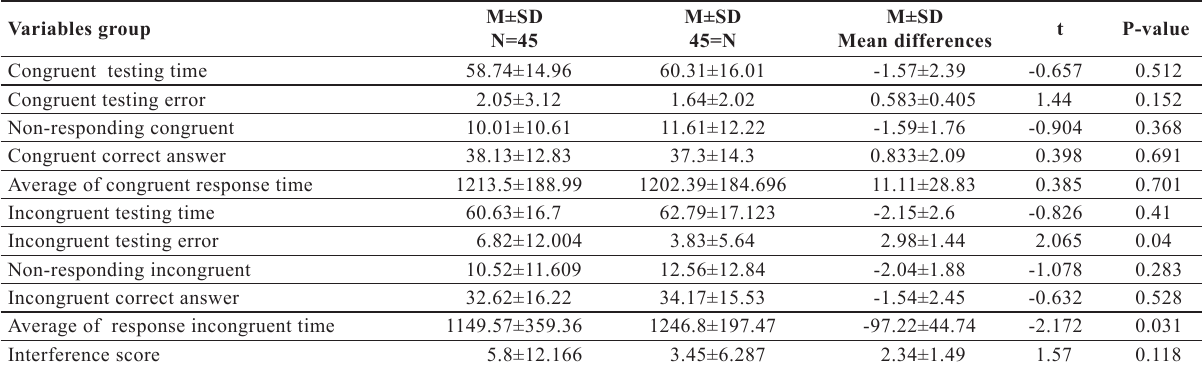
Table 3. Comparative assessment of mean, SD, t and p-value of variables in SAT test variables among men and women